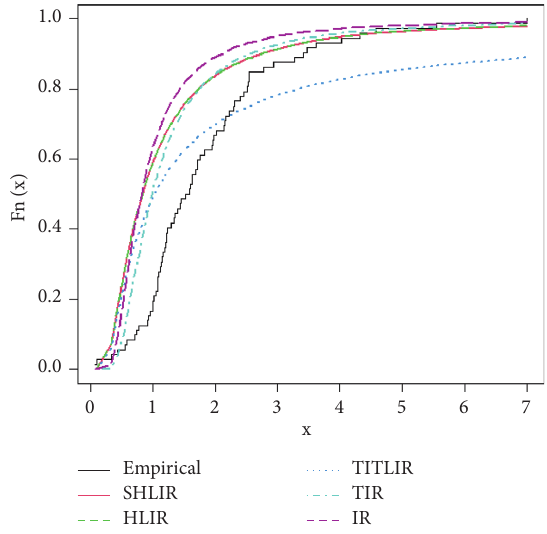
Figure 3: Fitted CDFs of models for data